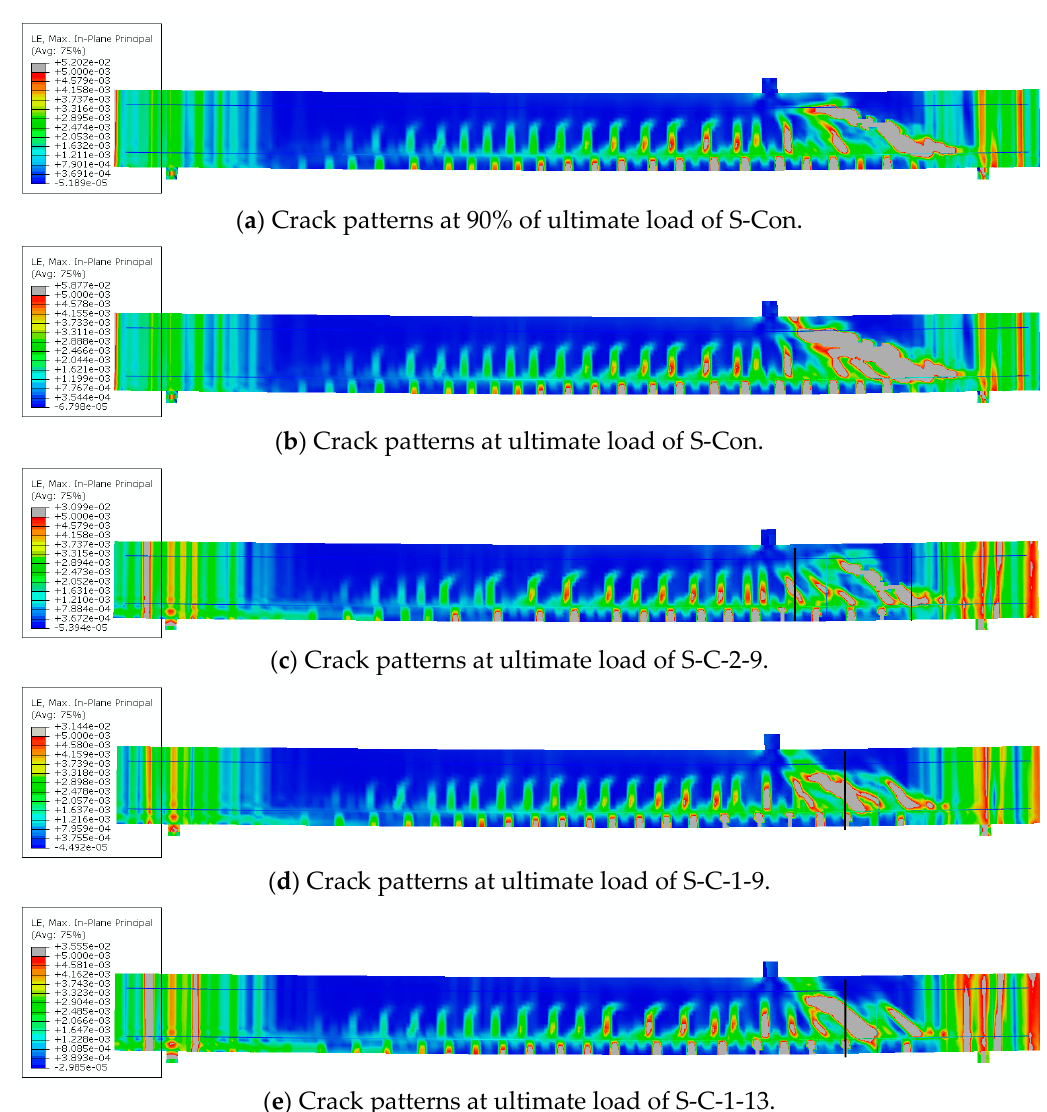
Figure 21. Finite element (FE) crack patterns of test slabs.